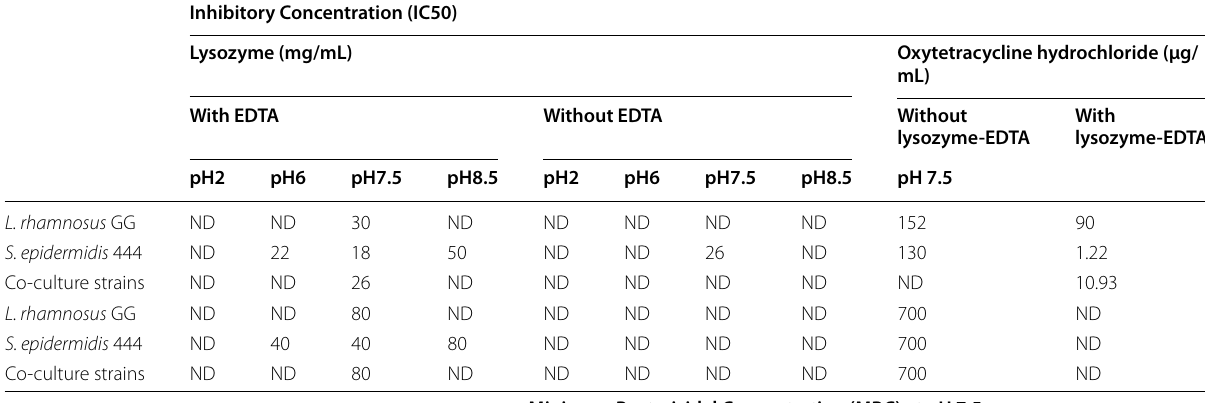
Table 1 Comparative table between the different MIC, IC and the co-culture of both strains